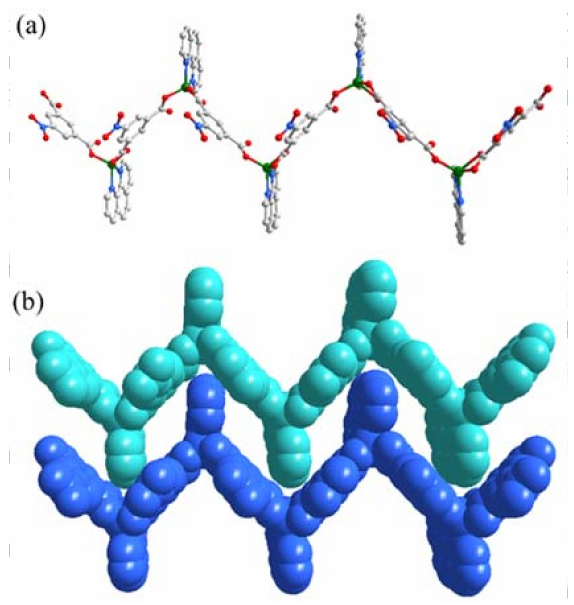
Figure 2. The infinite 1D zigzag chain of Complex ( a ); the 1D supramolecular double-chain in Complex ( b